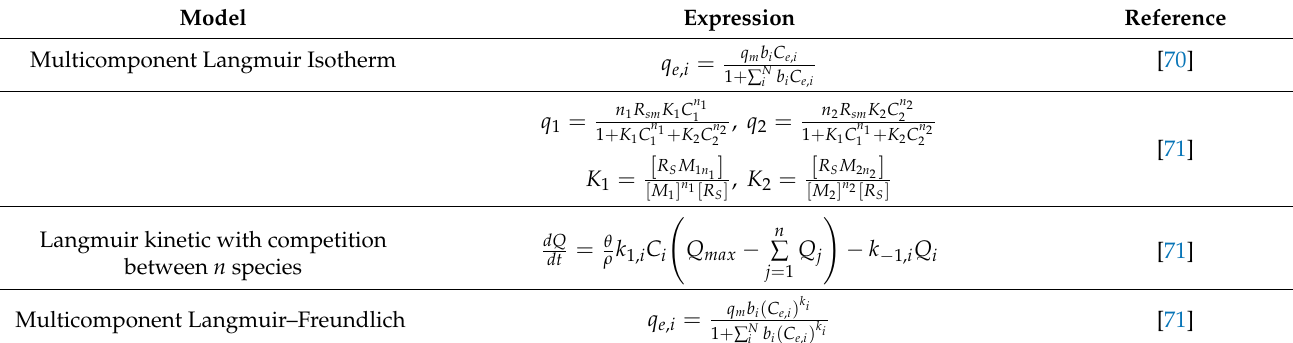
Table 3. A brief list of multicomponent Langmuir and Freundlich